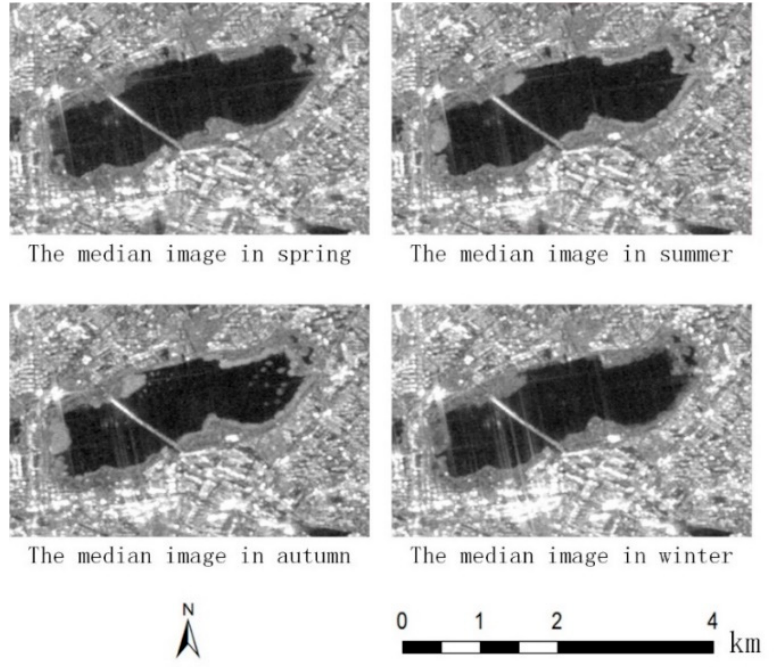
Figure 3. A sample of Sentinel-1 data. The grayscale images of the VV band were shown.